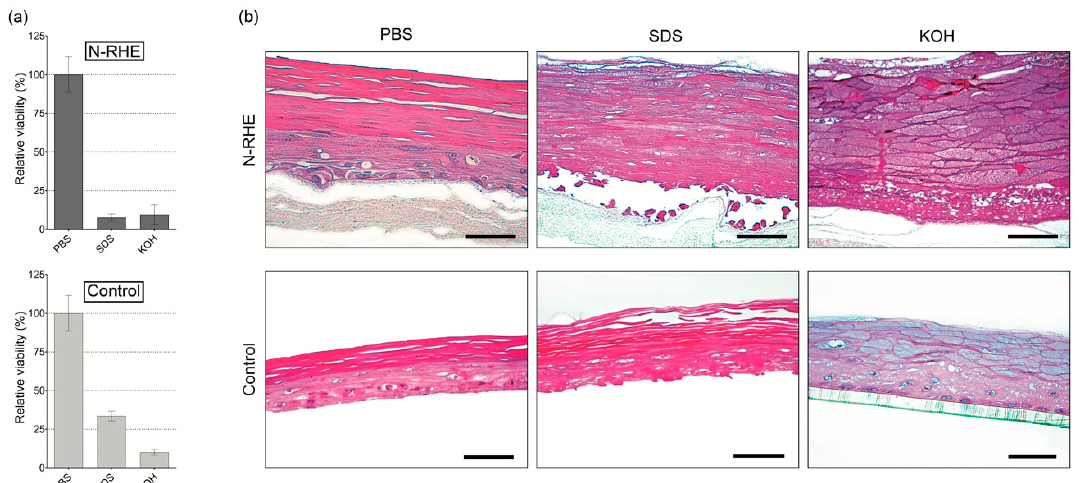
Figure 6. In vitro evaluation of skin irritation of N-RHE and control (USP-RHE) epidermal models: ( a ) relative cell viability testing, according to OECD TG 439. Results are expressed as mean ± standard deviation of two independent experiments (n = 2), each tested with three different tissue replicates; ( b ) Histological analysis of H&E stained vertical paraffin sections. Results were obtained after exposure to substances: PBS, SDS (5%), and KOH (5%). Bar = 50 μ m.